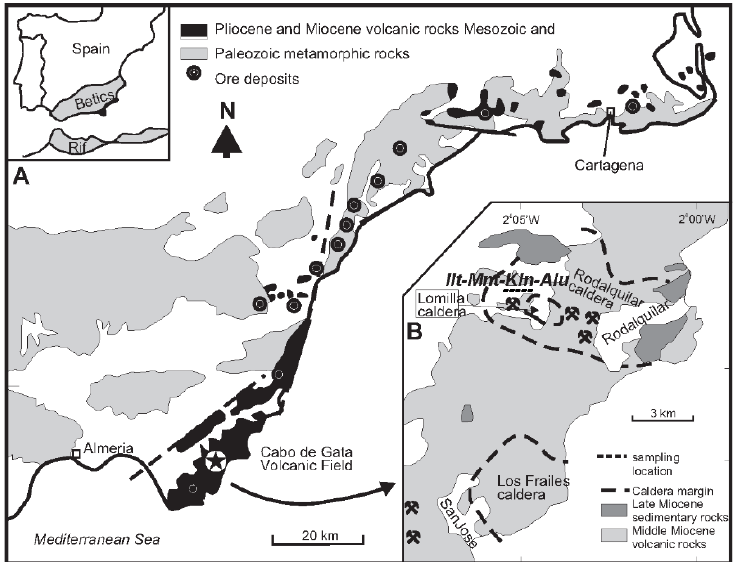
Figure 1. ( A ) The Rodalquilar area with sample locations. ( B ) Detail of the area with typical alteration minerals for epithermal gold deposits: illite (Ilt), montmorillonite (Mnt), kaolinite (Kln) and alunite (Alu). Modified with permission after van der Meer et al. [11]. Mineral abbreviation according to Whitney and Evans [12].